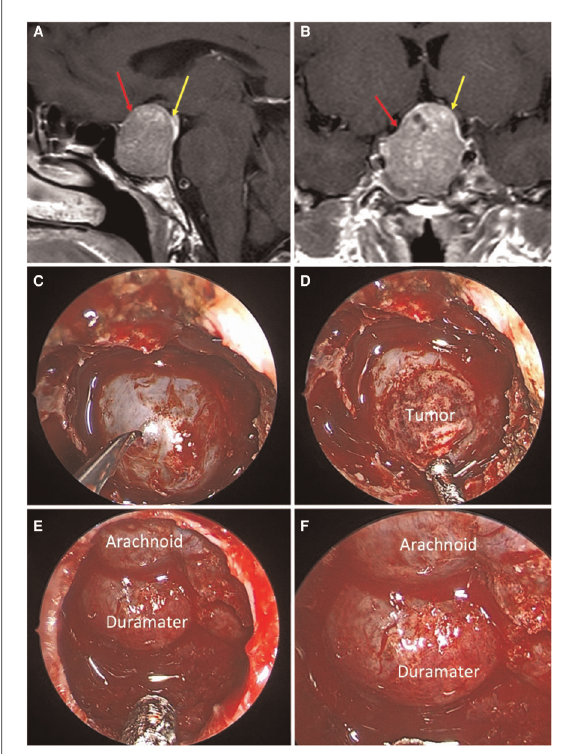
FIGURE 2 Mixed sellar barrier. A 59-year-old female patient, with a PRL produced macroadenoma. ( A,B ) Preoperative MRI: the yellow arrows indicate the barrier that captures contrast with a thickness greater than 1 mm and the red arrows indicate the barrier that captures contrast with a thickness less than 1 mm. ( C – F ) Intraoperative images: the barrier constituted by duramater and arachnoid can be